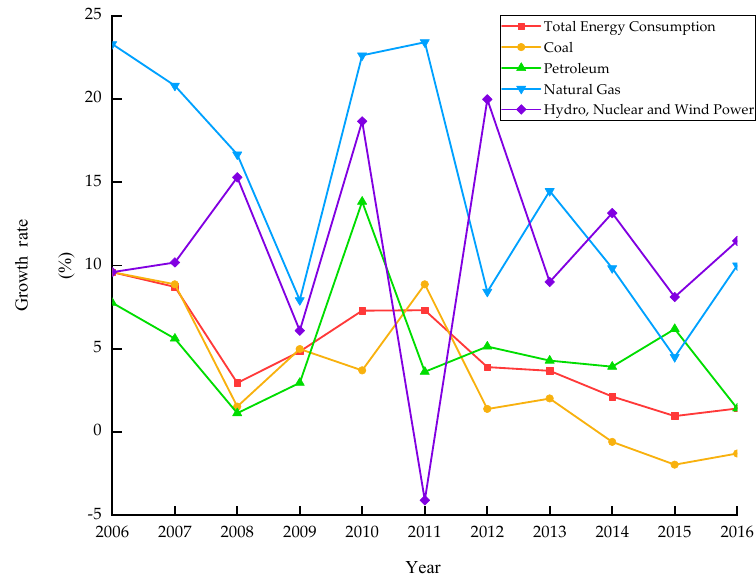
Figure 7. The energy consumption growth rate in China.